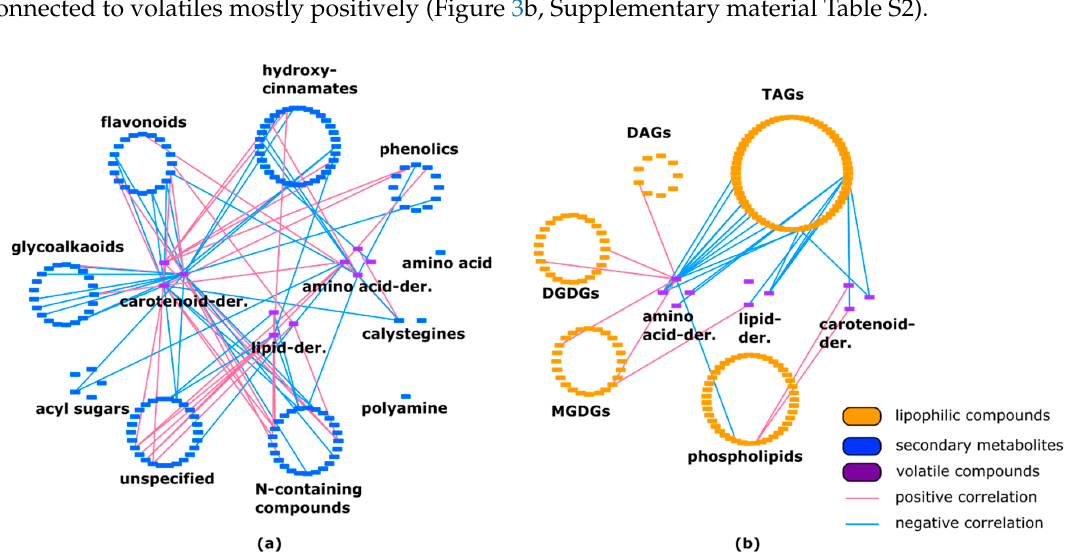
negative connections with all types of volatile compounds. DAG—diacylglycerol; TAG—triacylglycerol; DGDG—digalactosyldiacylglycerol; MGDG—monogalactosyldiacylglycerol.